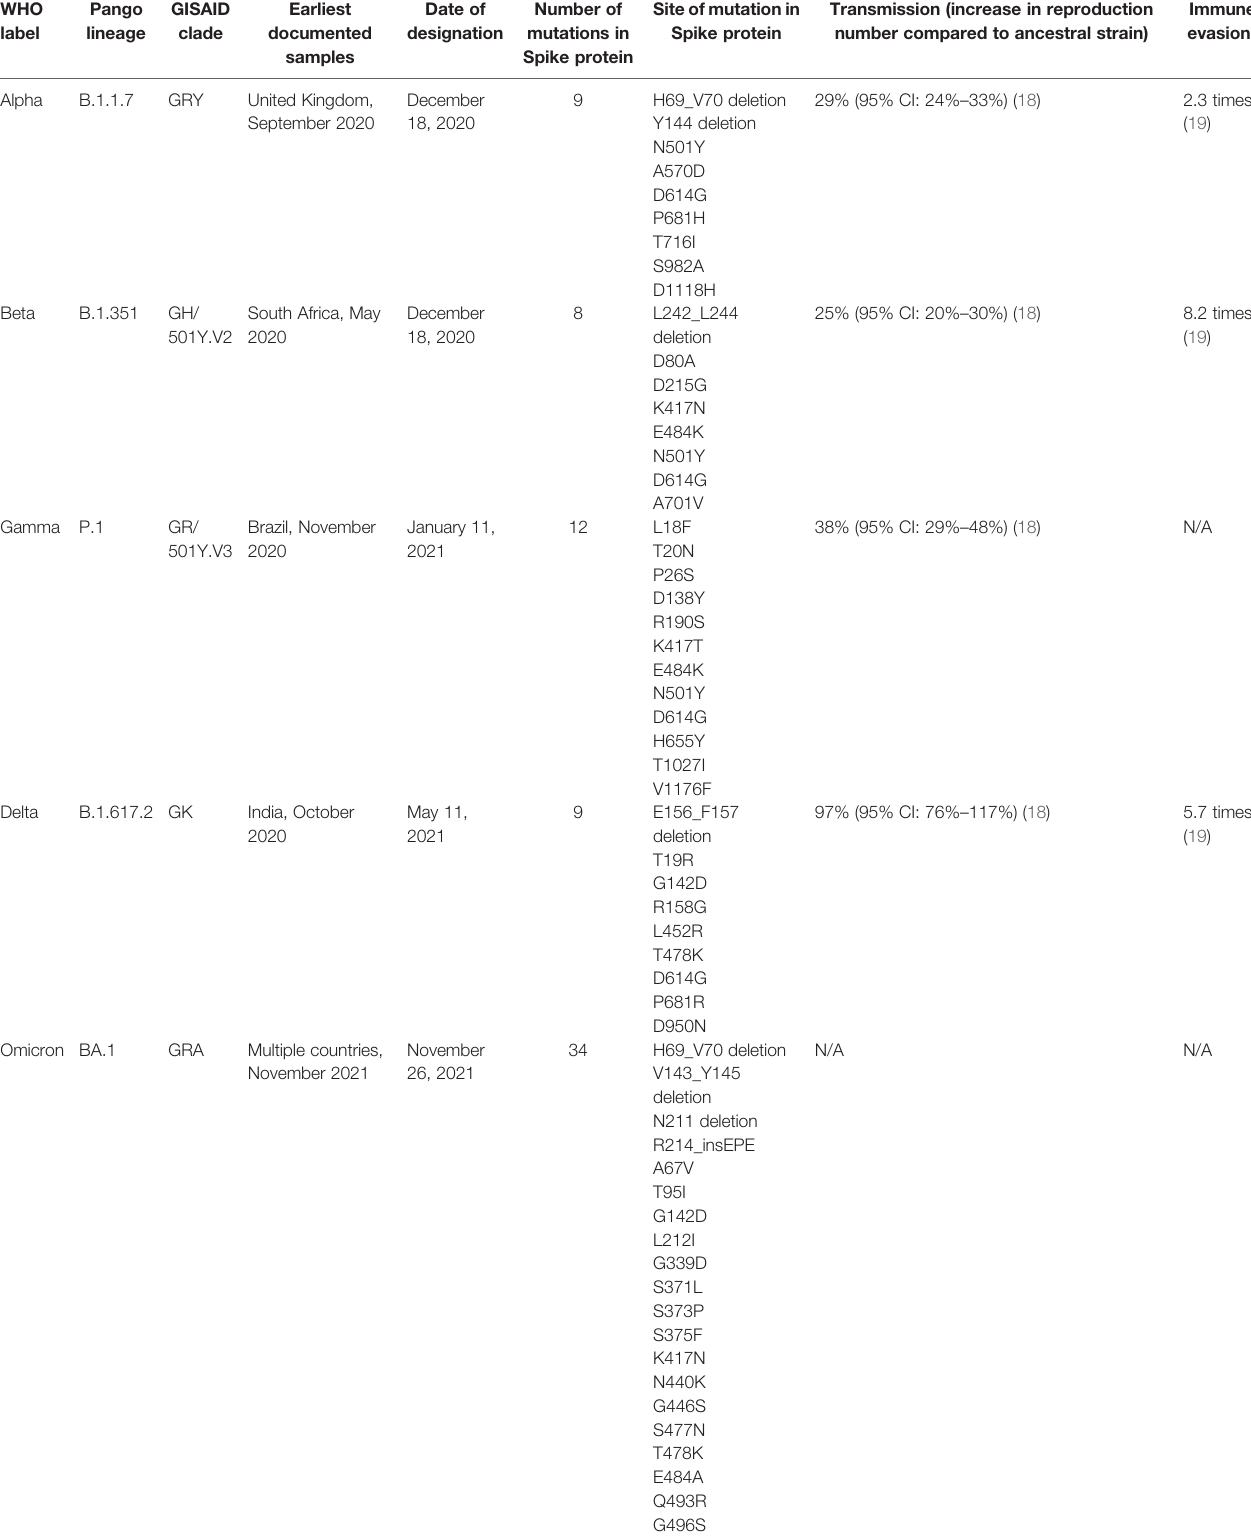
TABLE 1 | The summary of variants of